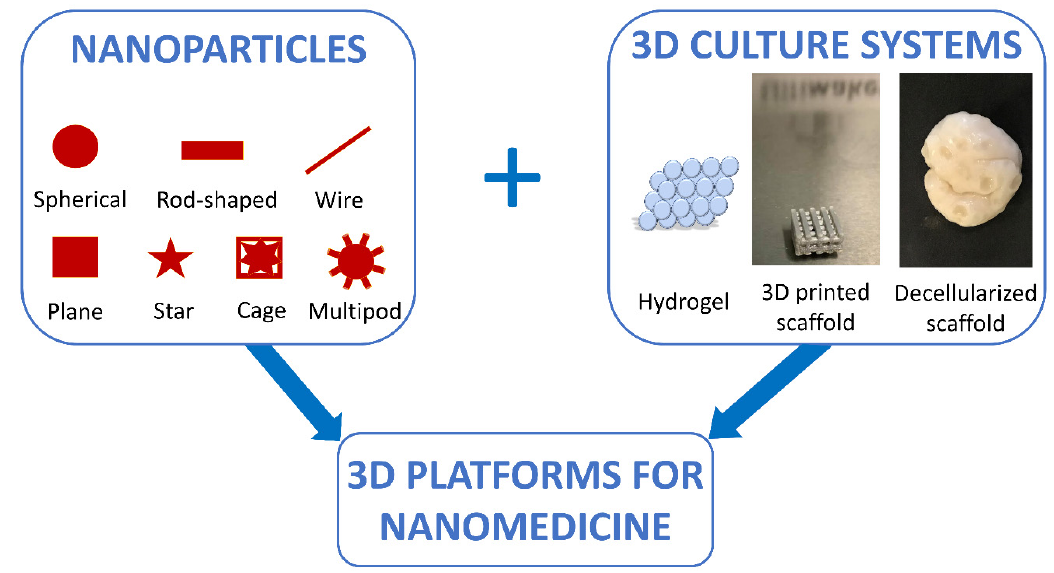
Figure 5. Nanomedicine approaches are improved through a combined use of NP-based techniques and 3D culture sys- tems.